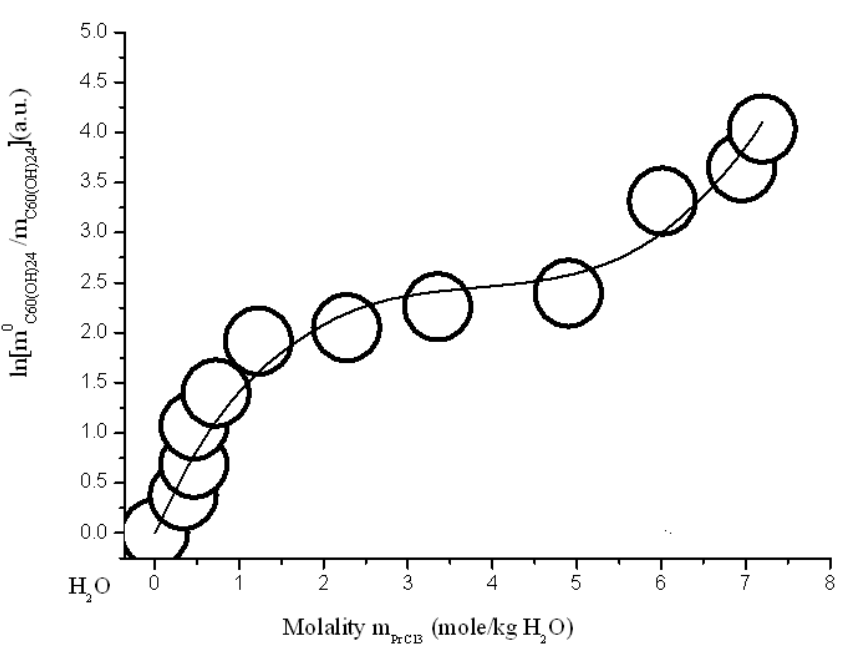
Figure 15. Branch of crystallization C 60 (OH) 24 *18H 2 O in the diagram of solubility in ternary system C 60 (OH) 24 —PrCl 3 —H 2 O at 25 ◦ C (convex-conxave σ − id line—calculation according to modified three-parameter Sechenov equation SEM-3 (15)).